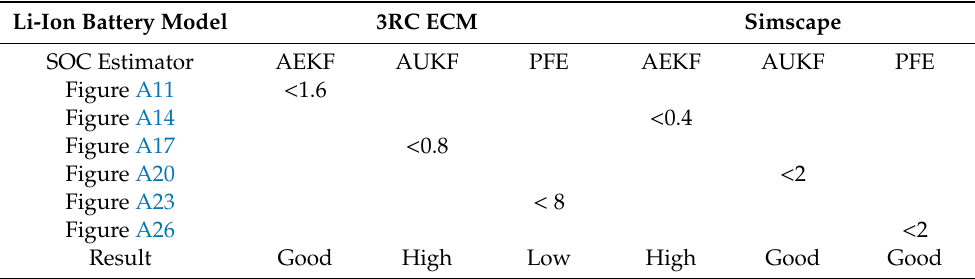
Table 3. The Li-ion SOC estimator accuracy based on the SOC residual error (%). Li-Ion Battery